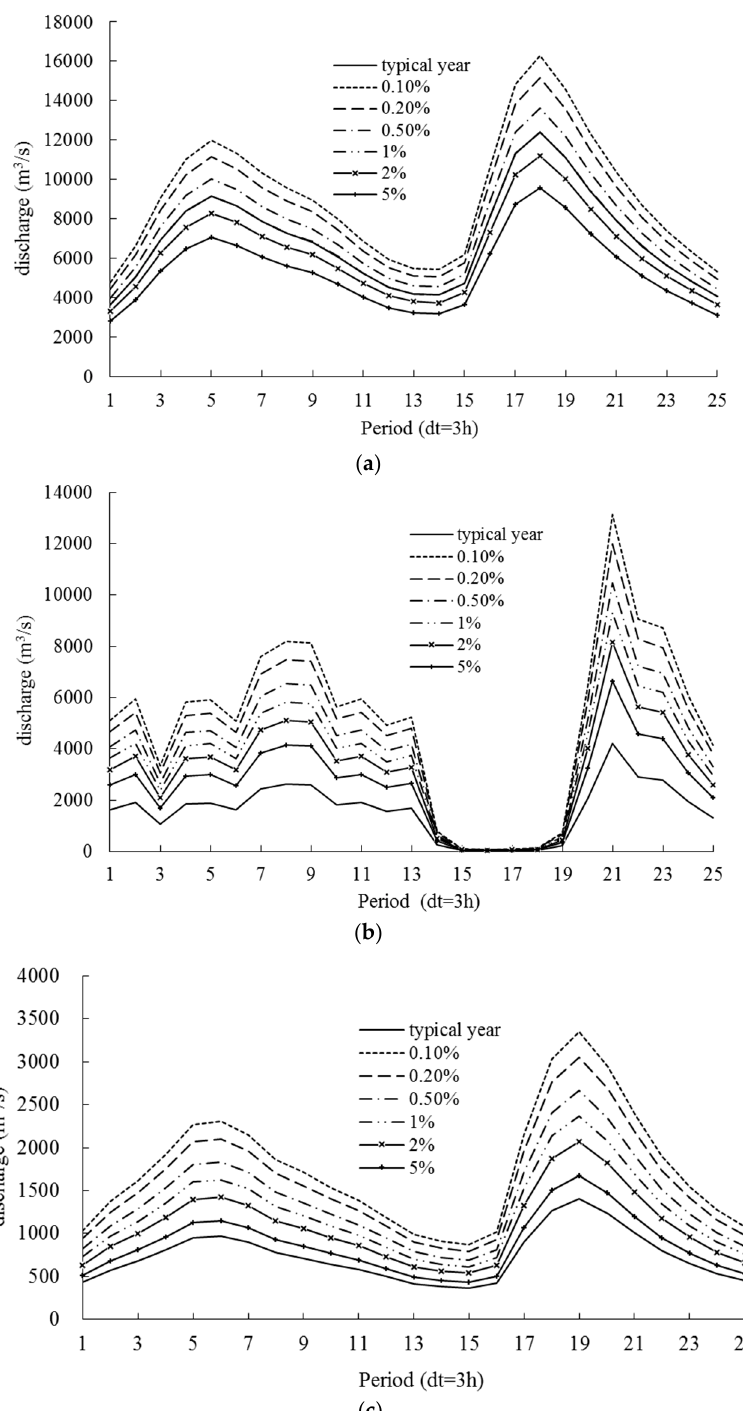
Figure 5. Design inflow hydrographs at three sub-basins for cascade reservoirs. ( a ) Shuibuya basin; ( b ) Shui-Ge inter-basin; and, ( c ) Ge-Gao inter-basin. Table 7. Design peak discharges at Gaobazhou site with different return periods under the impact of Shuibuya-Geheyan cascade reservoirs operation (m 3 /s).